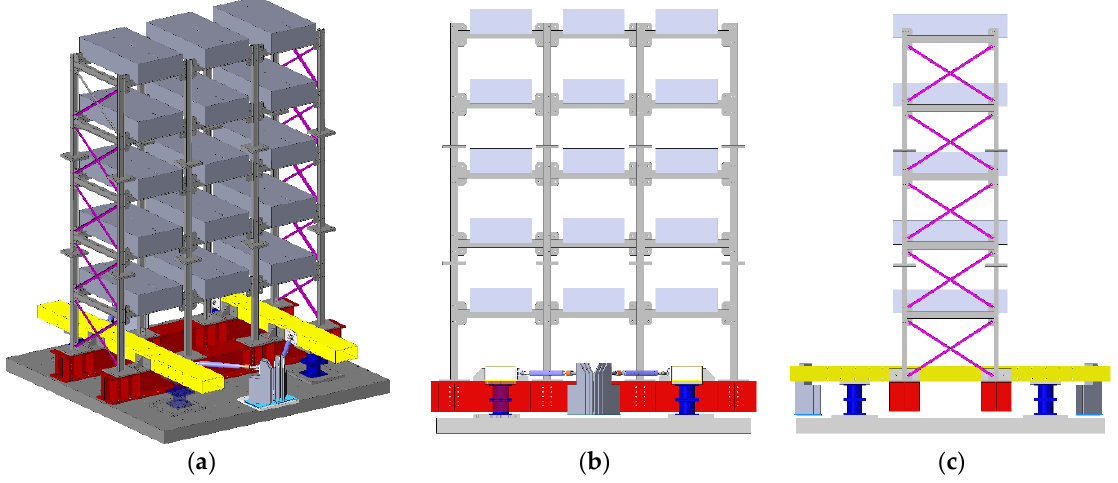
Figure 1. Model structure: ( a ) Steel structure model on the shaking table; ( b ) front and ( c ) side elevations of the steel structure model on the shaking table.